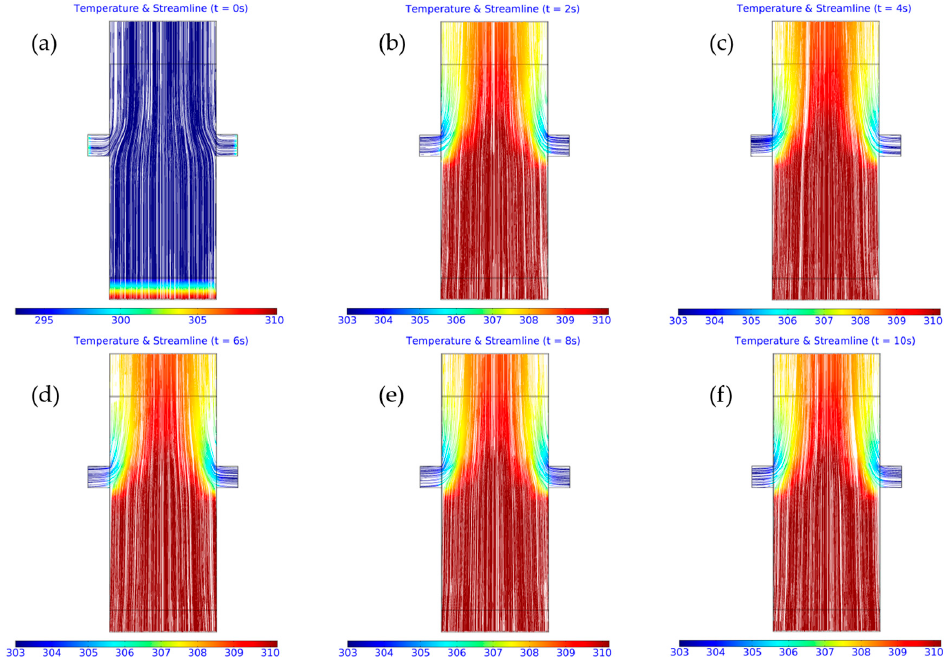
Figure 13. Distribution of flow streamlines and temperature over the mixing chamber without obstacles at: ( a ) 0 s; ( b ) 2 s; ( c ) 4 s; ( d ) 6 s; ( e ) 8 s; and ( f ) 10 s. Different temperatures are represented by different colors as shown in the color bar (in K).